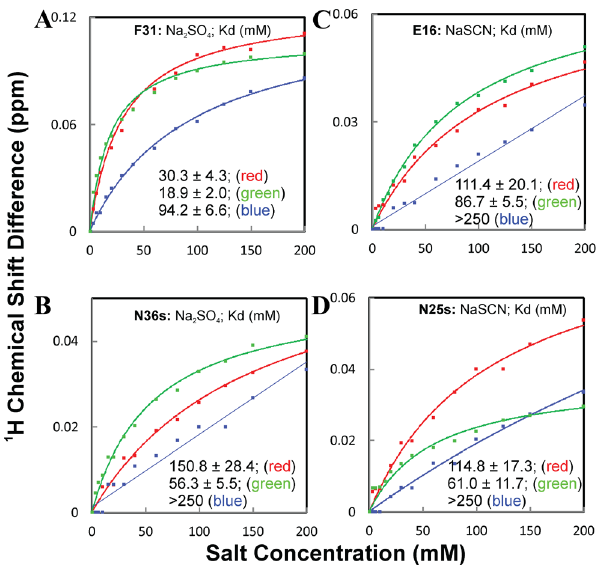
Figure 21. Apparent dissociation constants for representative amide protons of WW4. ( A )–( B ) Residue-specific apparent dissociation constants (Kd) for backbone amide proton of Phe31 and side-chain amide proton of Asn36 titrated by Na different conditions. ( C )–( D ) Residue-specific apparent dissociation constants (Kd) for backbone amide proton of Glu16 and side-chain amide proton of Asn25 titrated by NaSCN under different conditions. Experimental (dots) and fitted (lines) values are shown for the 1 H chemical shift changes induced by gradual addition of two salts (Na SO and NaSCN). Red is for the data in water (pH 6.4), green 2 4 for those in water (pH 4.0), and blue for those in 20 mM sodium phosphate buffer (pH 6.4).